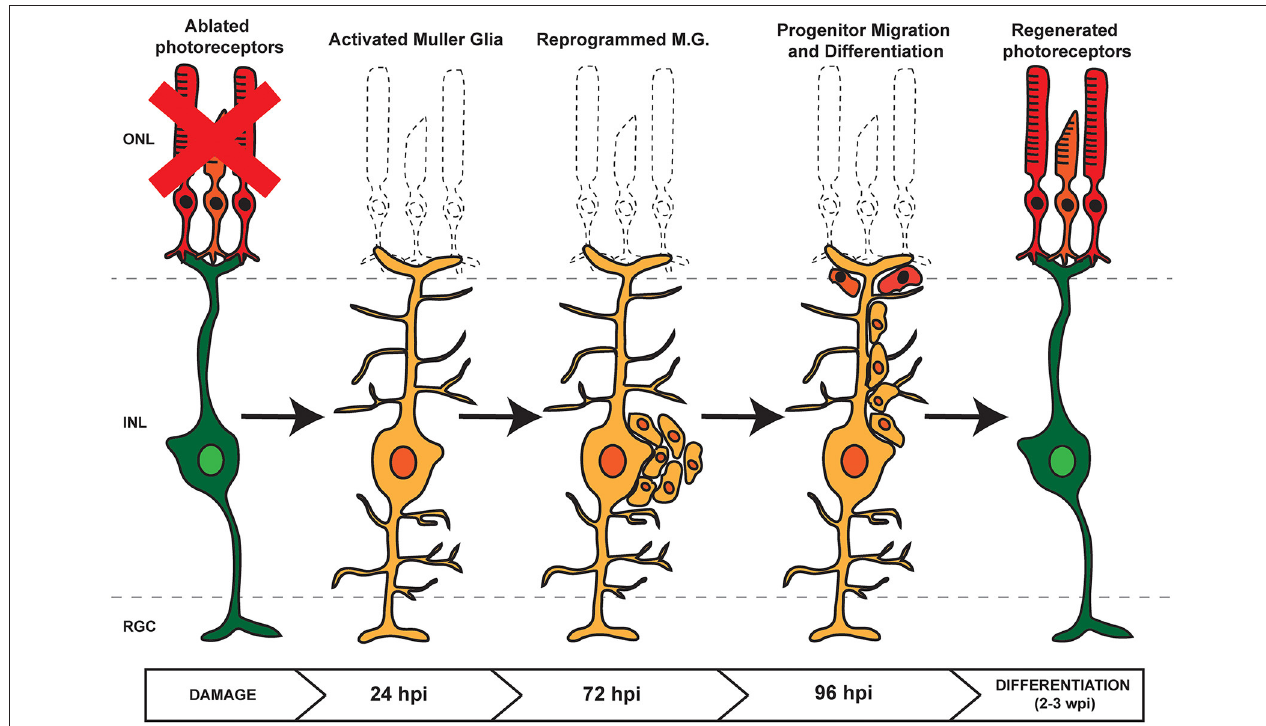
FIGURE 1 | Retina Regeneration in Zebrafish. In response to retinal damage or cell loss, zebrafish Müller Glia (MG) are activated and undergo dedifferentiation. Asymmetric division allows for self renewal and the generation of proliferating retinal progenitor cells (RPCs) which cluster along MG processes. As regeneration proceeds, the RPCs migrate to the site of damage before differentiating into any lost or damaged cell types.